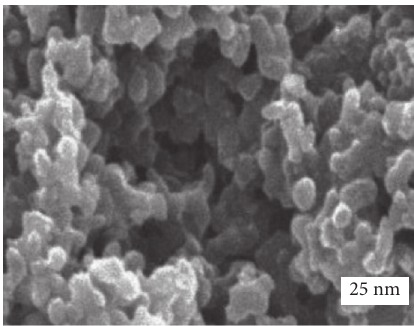
Figure 2: Morphology of α -phase nano Al